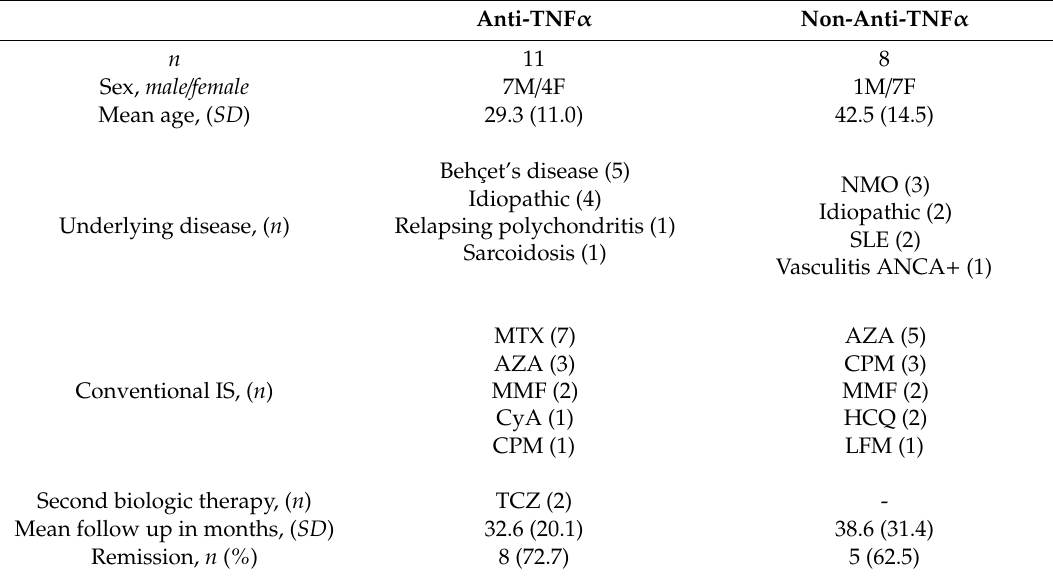
Table 2. Comparison of patients treated with anti-TNF α and with non-Anti-TNF α